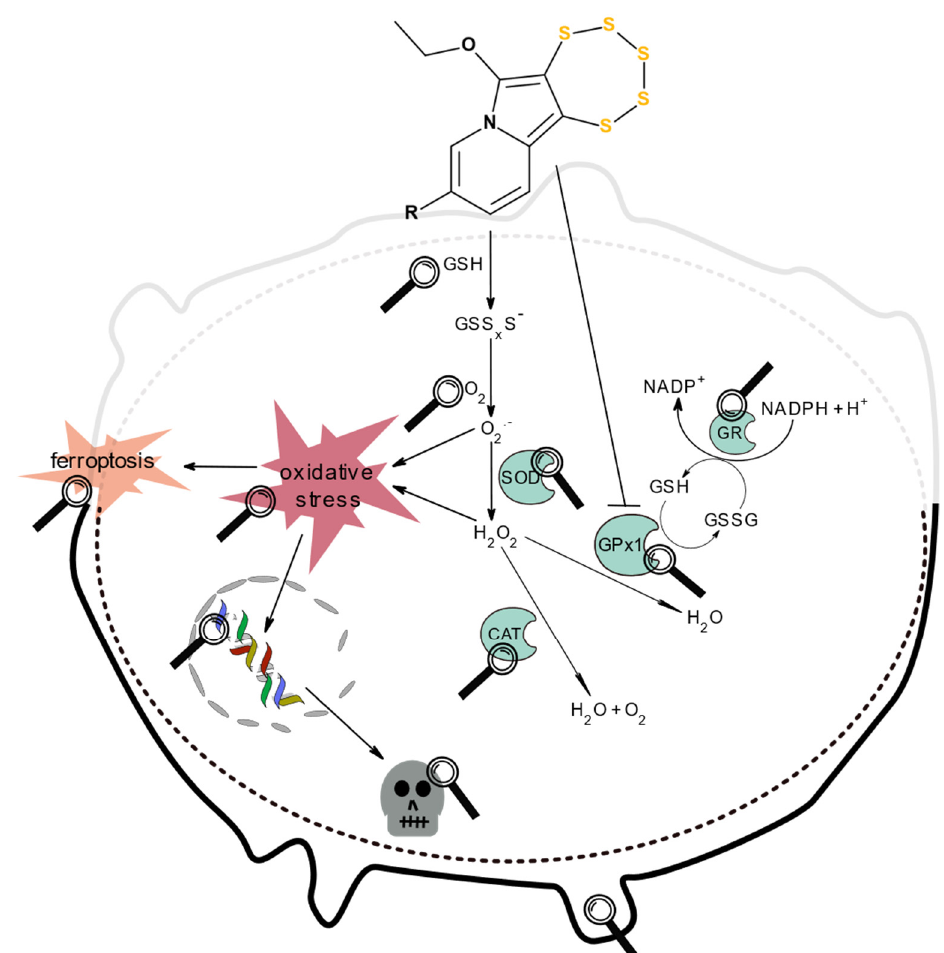
Figure 3. The mechanism of action exerted by pentathiepins in terms of the postulations of previous studies and adapted in order to clarify the objectives for the current comprehensive biological evaluations [12,24]. Magnifying glasses highlight the subjects of the present